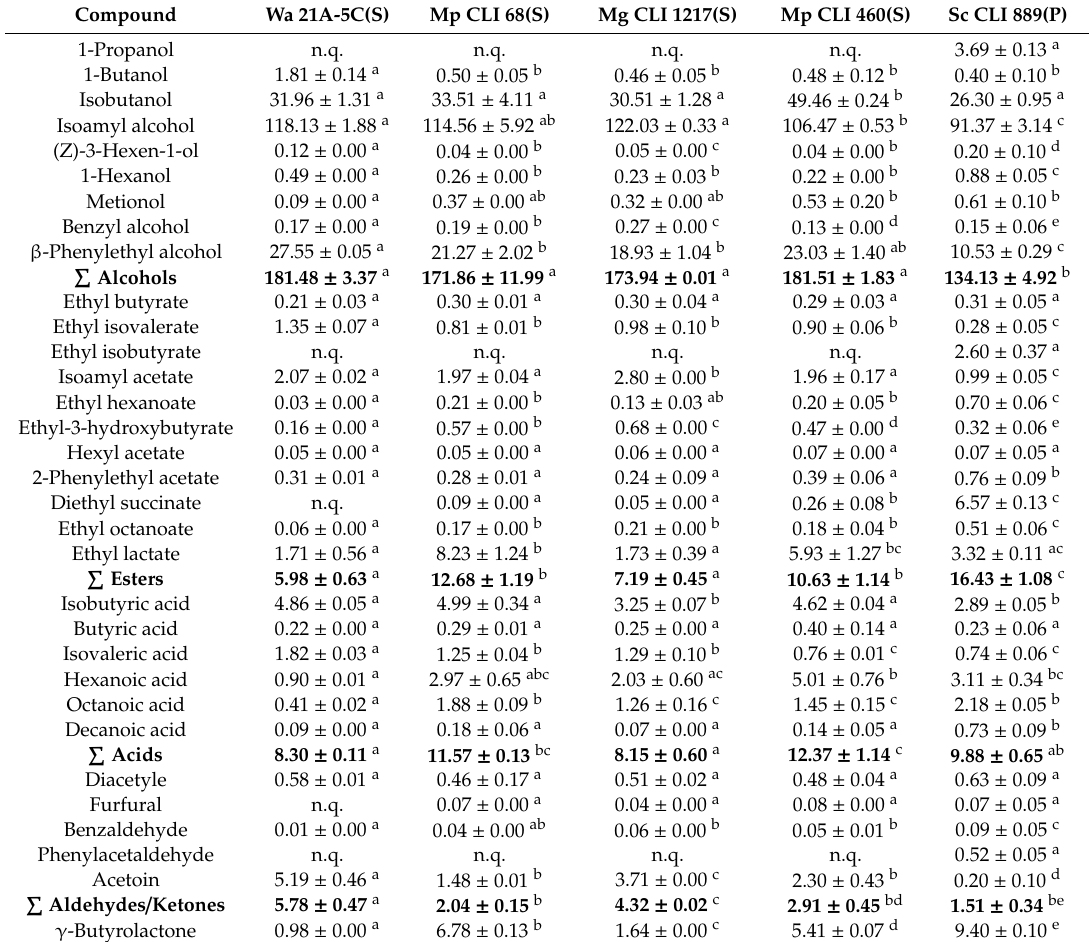
Table 3. Major volatile compounds (mg / L) of wines produced in the Section II (sequential culture of non- Saccharomyces strains + S. cerevisiae CLI 889 and a control, S. cerevisiae CLI 889 pure culture).